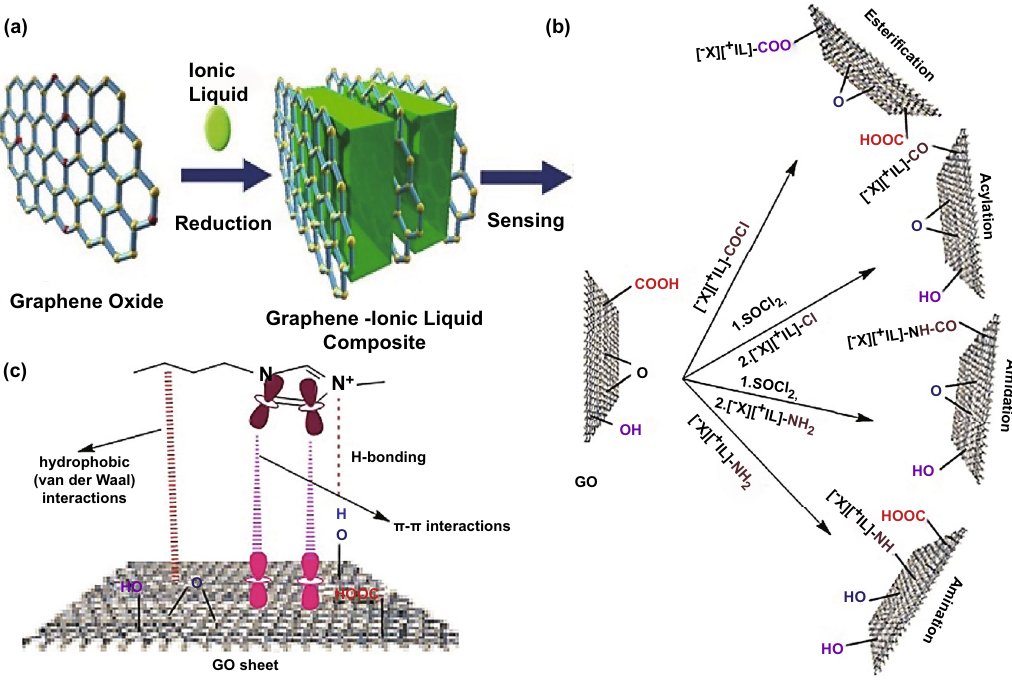
Fig. 9 a Schematic view of the GO/rGO synthetization and functionalization via ILs for sensing applications. Reproduced with permission from Ref. [129] Copyright © 2010, Wiley ‐ VCH Verlag GmbH & Co. KGaA, Weinheim. b Schematic view of GO covalent functionalization. c Sche- matic view of GO non–covalent functionalization. Reproduced with permission from Ref. [21] Copyright © 2018, Springer